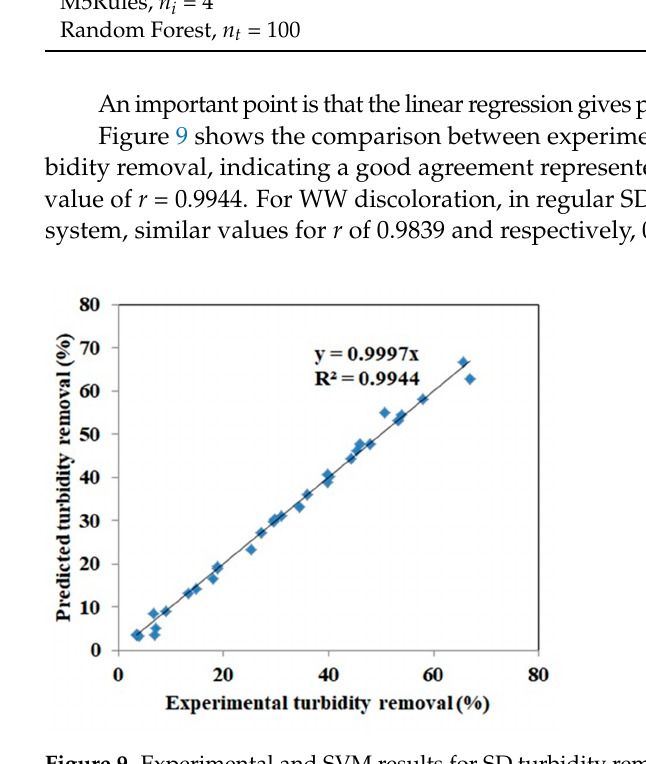
Figure 9. Experimental and SVM results for SD turbidity removal.